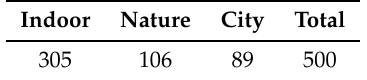
Figure 6. Basic Concept of Feature Extraction. The white box represents convolution and pooling layers in convolutional neural networks (CNNs), which are used for extracting features of an image. This part is not trained during transfer learning process. The green box represents fully connected layer in CNNs, which operates as classifier. This part is trained during whole training process. Table 1. The number of images for each class in our custom